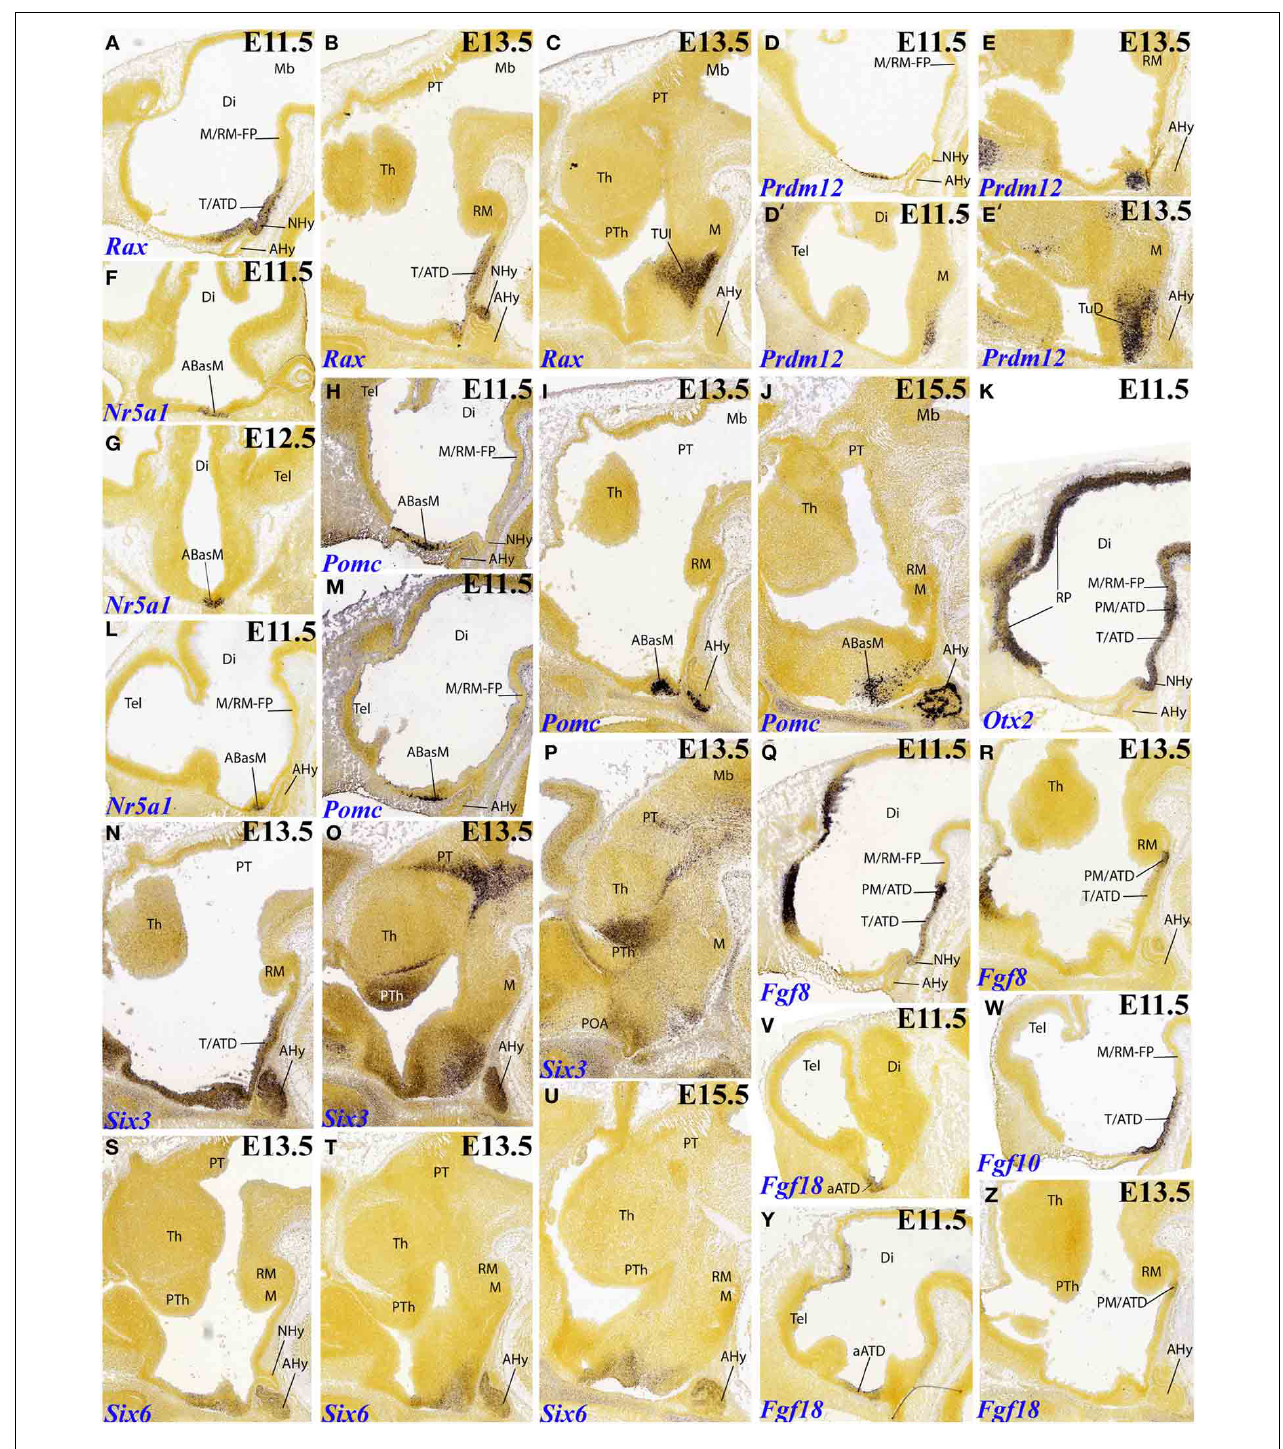
FIGURE 2 | Sagittal, parasagittal (A,B–E,H–Z) and horizontal (F,G) sections through the mouse secondary prosencephalon and diencephalon at E11.5, E13.5, and E15.5, showing relevant examples of selective hypothalamic gene expression at the acroterminal domain (ATD) and terminal territory: Rax (A–C),